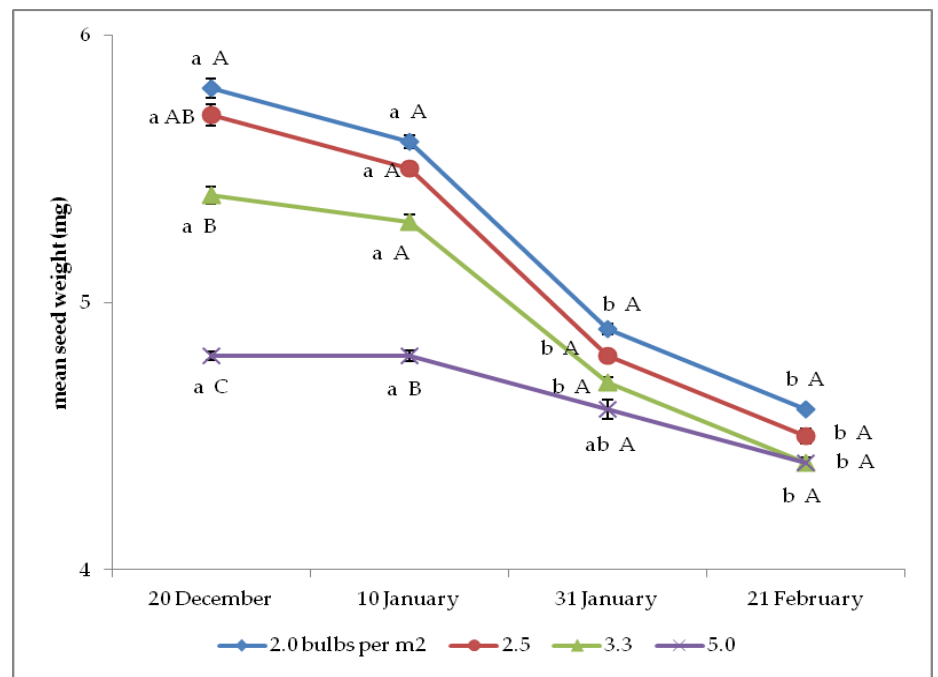
Figure 5. Interaction between bulb planting time and density on onion mean seed weight ( n = 3). Different letters mean significant difference in the comparison between planting times (lowercase letters) or between bulb densities (capital letters), according to the Duncan test at p ≤ 0.05. Standard deviation bars are shown per each value.